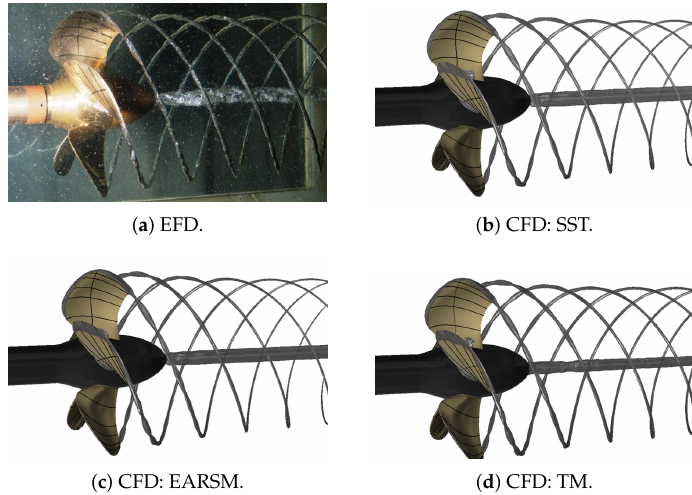
Figure 7. Comparison of model-scale cavitation patterns for the PPTC Case 1. The photograph from experiments is given in [26], and reproduced with permission from Lars Lübke